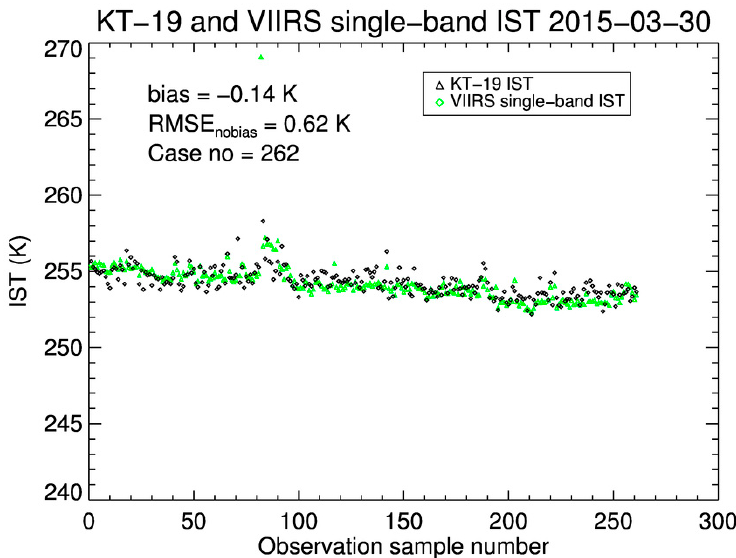
Figure 7. KT-19 ice surface temperature (IST) (black) and single-band IST from S-NPP VIIRS (green) along the P-3 Ice Bridge flight track around 22:17 UTC on 30 March 2015.